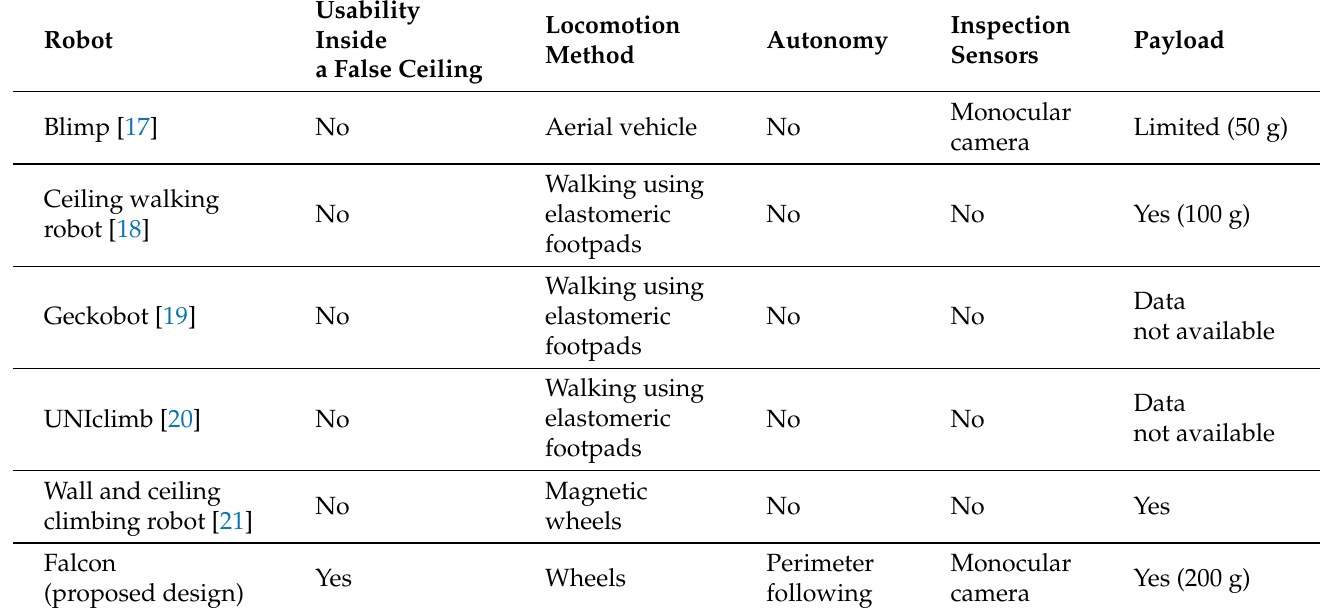
Table 1. Comparison of existing ceiling inspection robots and